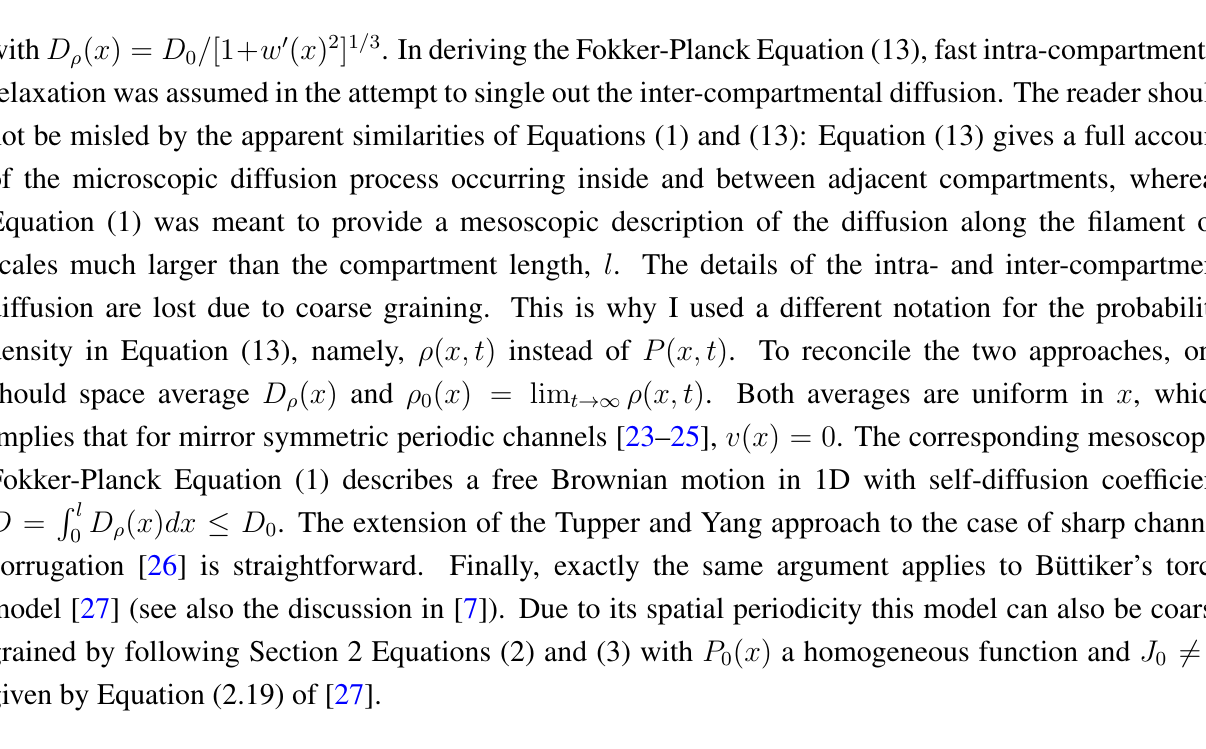
Figure 1. Sketch of the graded-channel geometries discussed in Section 3: ( a ) a symmetric periodic channel; ( b ) a graded compartment, length l ( x ) ; ( c ) a graded compartment, volume Ω( x ) ; and ( d ) graded pore